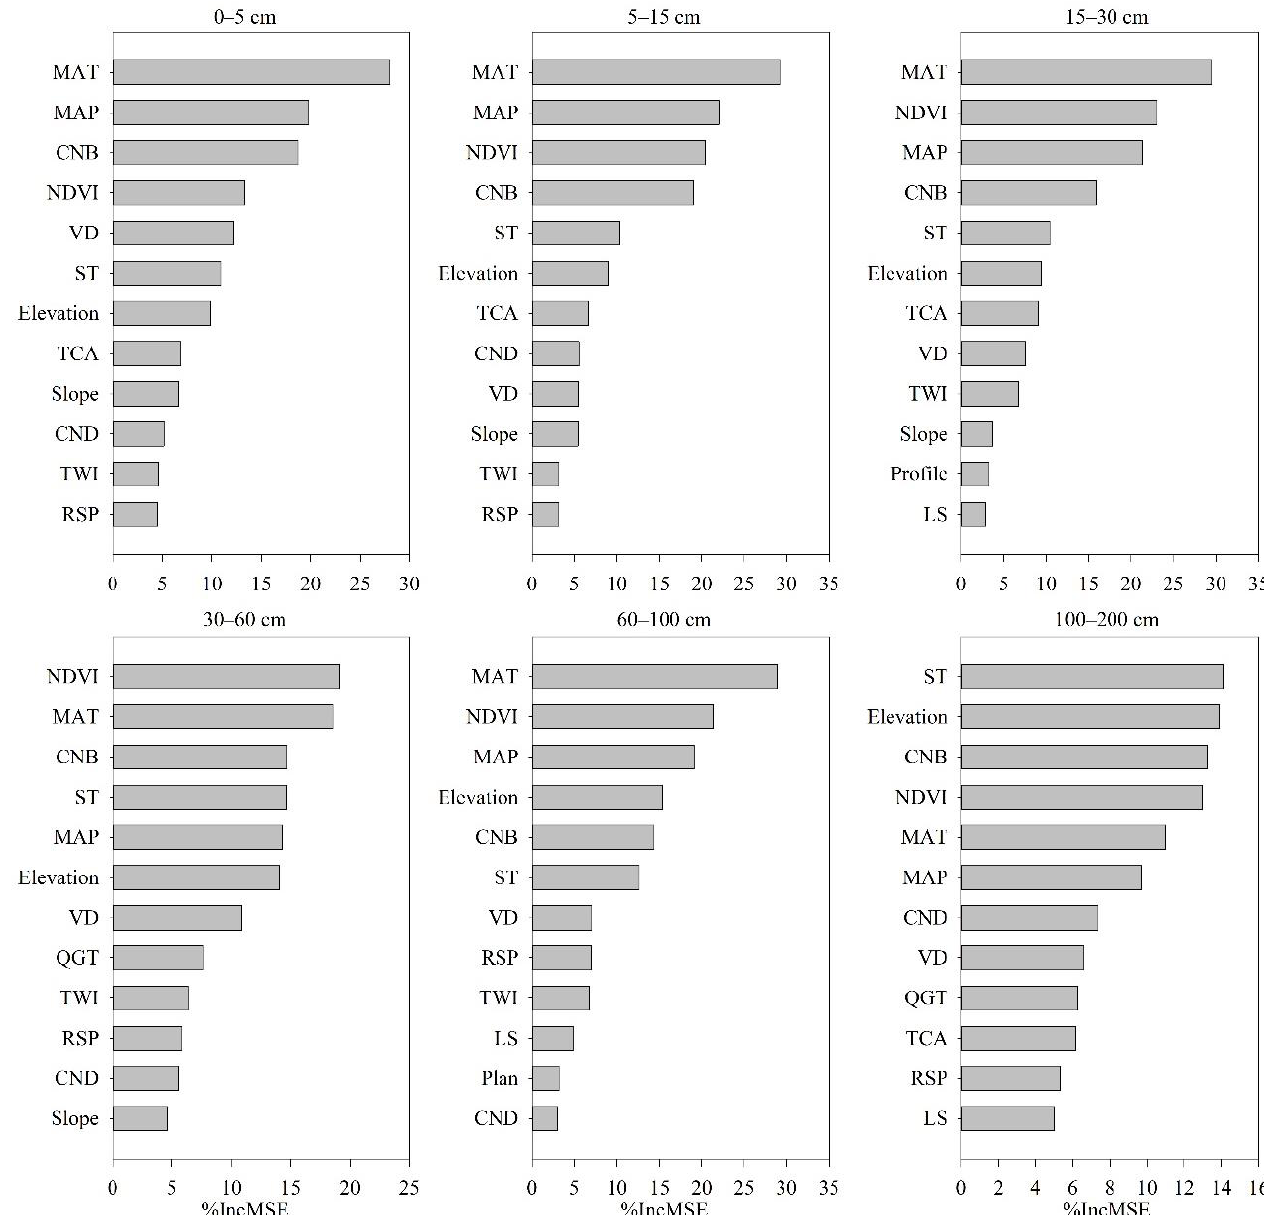
Figure 7. Relative importance (%IncMSE) of the covariates for sand predictions. (MAT: Annual mean temperature; MAP: Annual precipitation; CNB: channel network base level; NDVI: Mean NDVI during the growing season; VD: valley depth; ST: Soil type; Elevation: Elevation above sea level; TCA: total catchment area; Slope: Slope gradient; CND: channel network distance; TWI: topographic wetness index; LS: Slope length and steepness factor; RSP: relative slope position; CI: convergence index; QGT: quaternary geological type; Aspect: Aspect gradient; Plan: Plan curvature; Profile: Profile curvature).